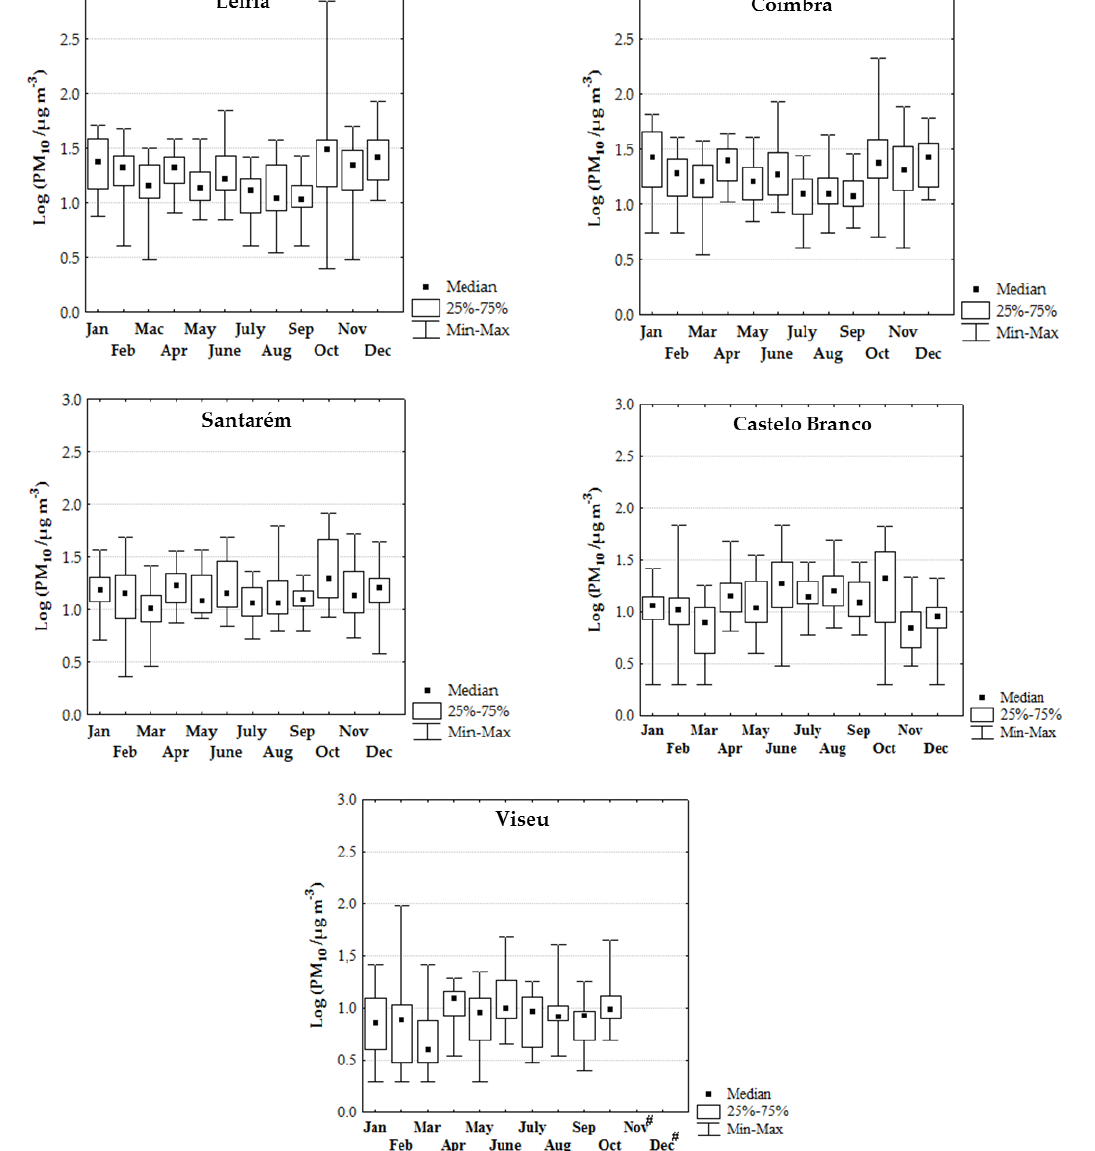
Figure 3. Log-transformed monthly concentrations of particle matter, PM 10 (median, percentiles 25–75, and range; µg/m 3 ) in the ambient air of the center region of Portugal. # Data were not available; * Data were only available until the 10 October.